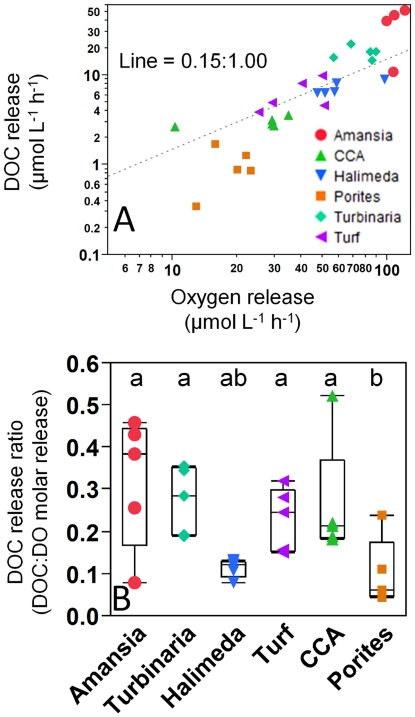
Relationships between oxygen and DOC release in Light incubations.Panel A relates absolute rates of oxygen and carbon production in light incubations, with line representing constant ratio of release for reference. Panel B shows variation in ratios of oxygen and DOC production among the six treatments; treatments with the same letter are not significantly different at α = 0.05. Quantile box plots in Panel B (whiskers extend to 95% quantiles) are overlaid with raw replicate data points from each treatment color/symbol coded according to the legend in panel (A).